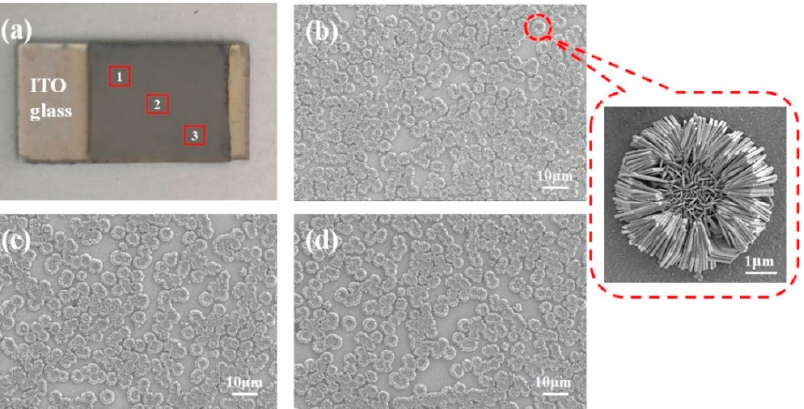
Figure 5. ( a ) Fabricated SERS substrate. ( b – d ) SEM images of the silver flower-like nanostructures in three different positions (scale bar 10 μ m).